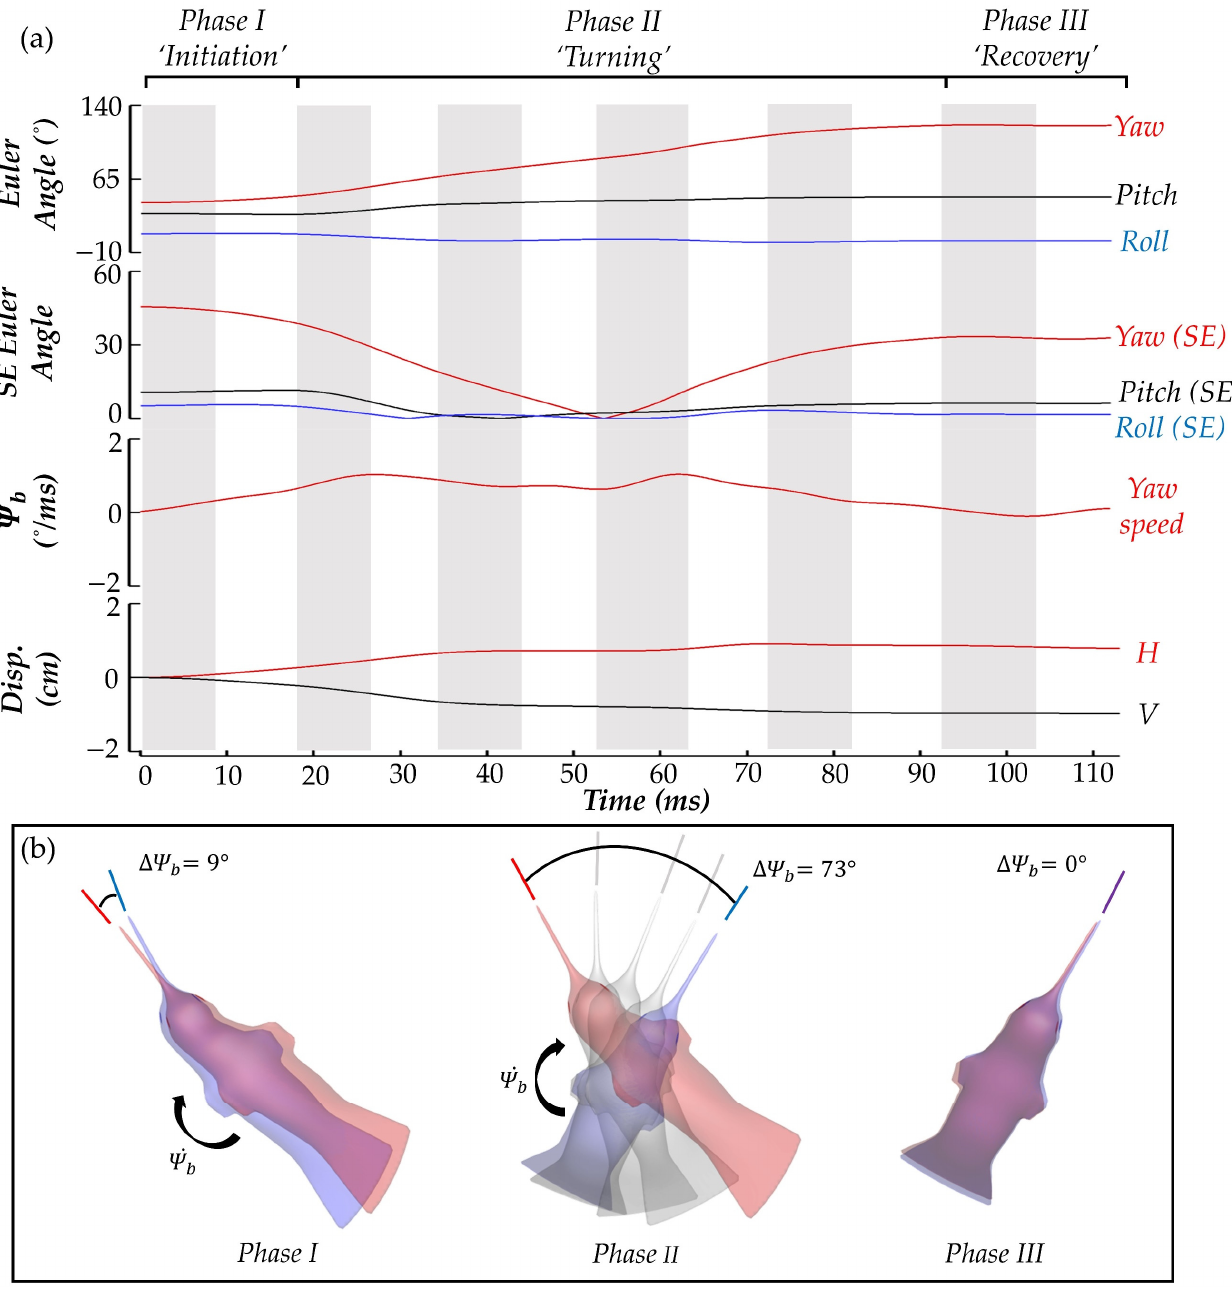
Figure 4. Summary of the body kinematics of the hummingbird including ( a ) body Euler angles, root squared error of the body Euler angles relative to the mean, plot of yaw angular velocity, and body horizontal (H) and vertical (V) displacements as well as ( b ) visualization of the yaw